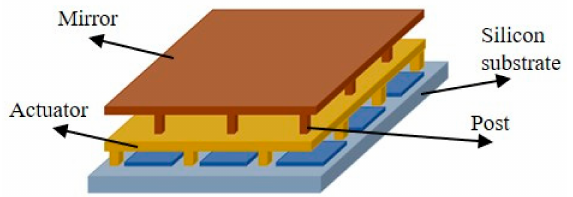
Figure 7. Schematic diagram of the partial continuous micromirror